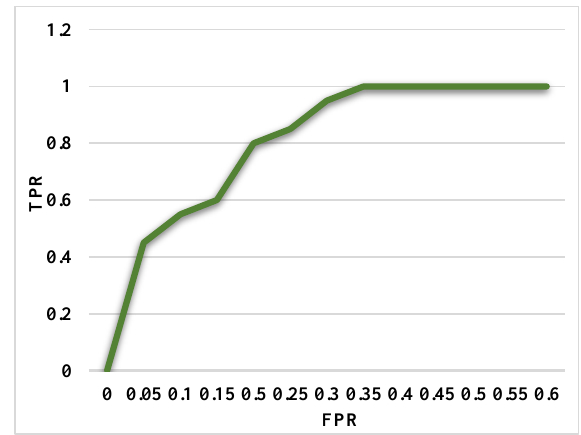
Figure 4. Confusion matrix for the BoT-IoT dataset.